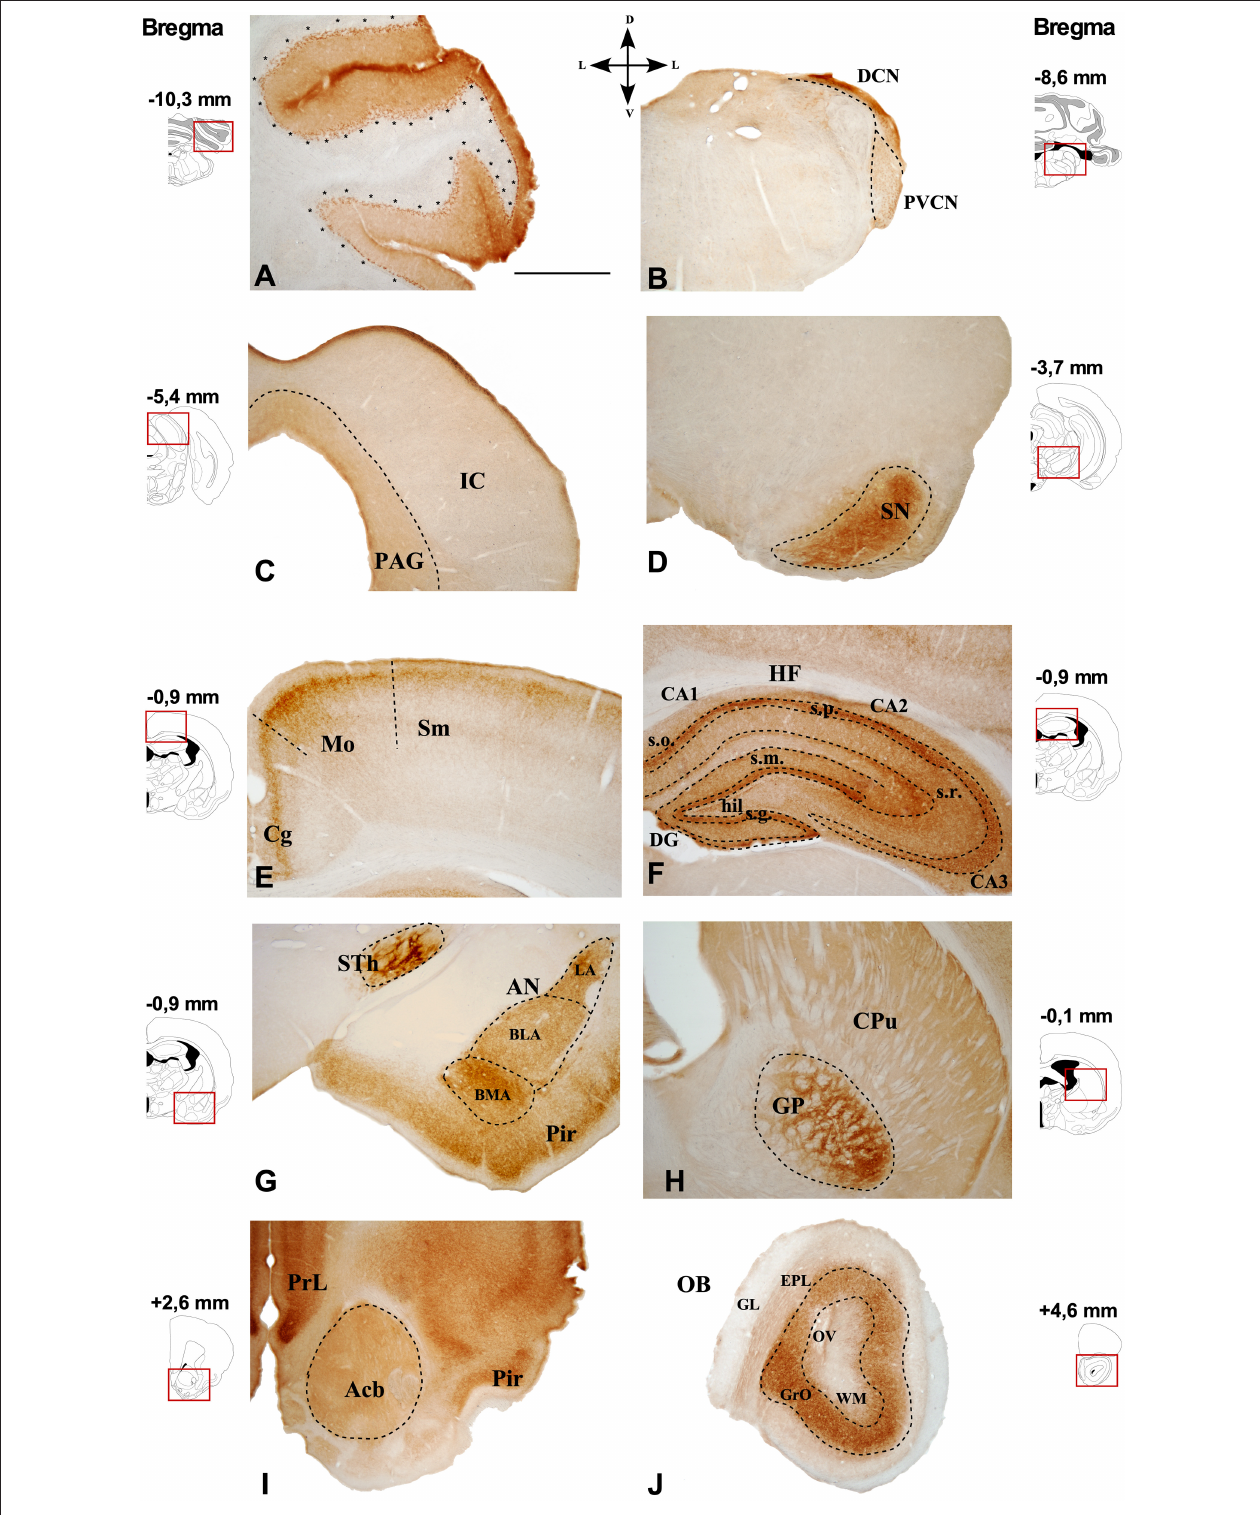
FIGURE 3 | Immunostaining of CB1R in the GASH/Sal brain. Photomicrographs of GASH/Sal coronal sections referencing their rostrocaudal position as a function of Bregma and indicating its dorsoventral orientation. (A) Cerebellar lobe. (B) Dorsal and posteroventral cochlear nucleus. (C) Periaqueductal gray matter (delimited by dots) and the inferior colliculus. (D) Substantia nigra. (E) Somatosensory and motor cortices. (F) Hippocampal formation. (G) Piriform cortex, amygdaloid nuclei, and